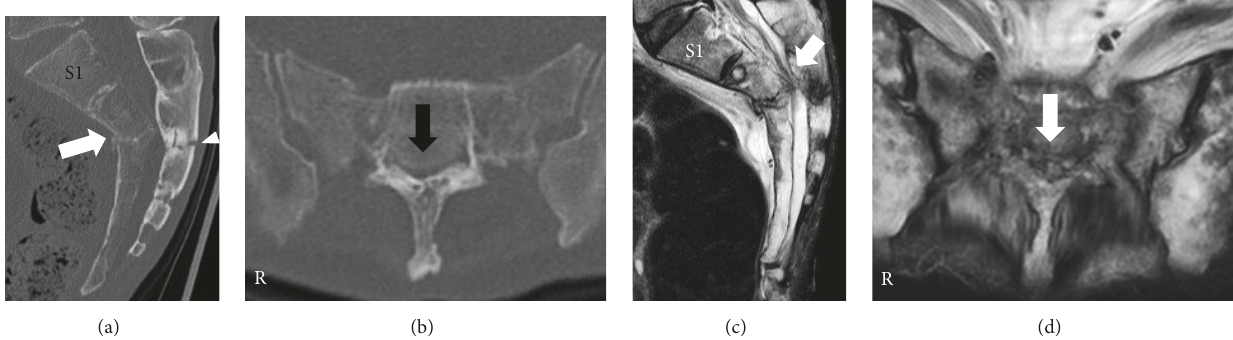
Figure 1: Reconstructed computed tomography (CT) and magnetic resonance images of sacrum at first hospital presentation . (a) Sagittal reconstructed CT image. (b) Axial CT image at S2-3 level. (c) Sagittal plane on a T2-weighted image. (d) Axial plane on a T2-weighted image. Fractures in the sacral vertebral body (white arrow) and lamina (white arrowhead) can be observed (a). Radiological findings were consistent with a Roy-Camille classification type I fracture [5]. Sacral canal was narrowed by the protruding sacral vertebral body (black arrow) (b). This radiological finding was diagnosed as a Denis Zone III sacral fracture [15]. Sagittal and axial plane on T2-weighted images showed that sacral nerves were compressed by the vertebral body (white arrow) (c, d).